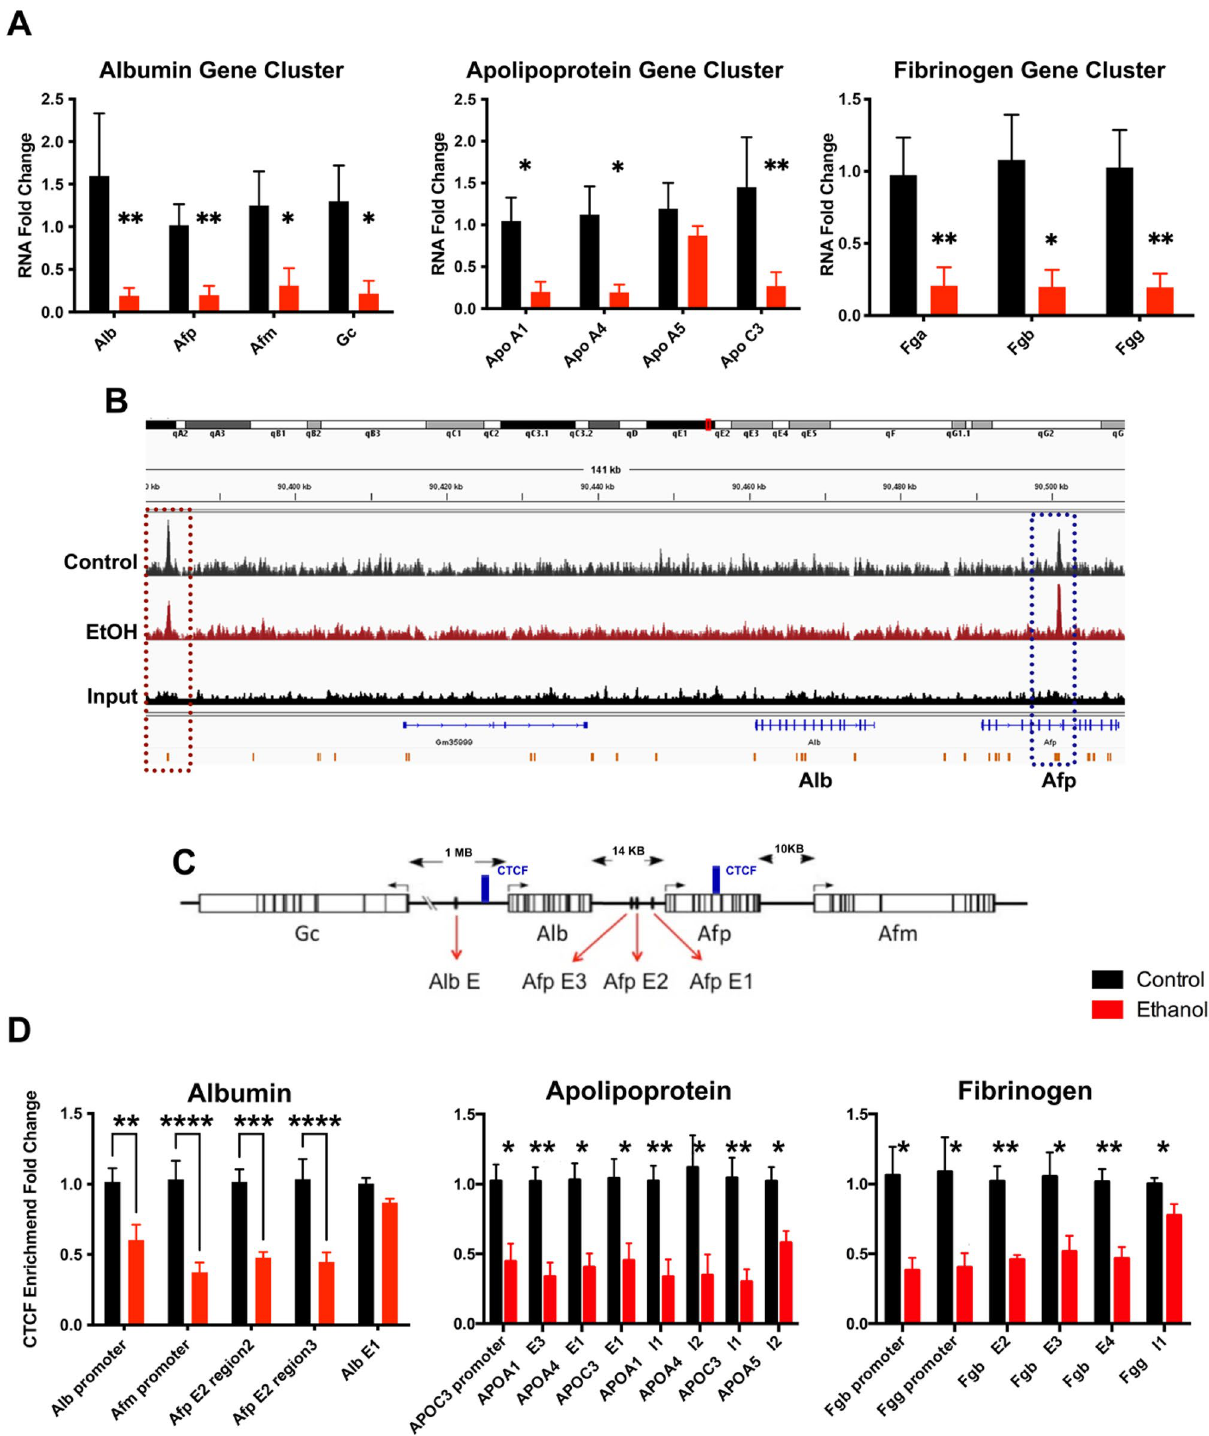
Figure 4. Preconception paternal alcohol exposure induces correlative patterns of altered gene expression and CTCF binding across the albumin, apolipoprotein, and fibrinogen gene clusters. ( A ) Using RT-qPCR and RNA samples isolated from male placentae derived from the offspring of EtOH-exposed sires, we assayed the expression of candidate genes within the albumin , apolipoprotein , and fibrinogen gene clusters. We normalized gene expression to the geometric mean of transcripts encoding Sdha , Mrpl1 , and Hprt and examined eight placentae from each treatment, derived from five different litters (n = 8). ( B ) Integrative Genome Viewer tracks showing altered CTCF enrichment within the albumin gene cluster. ( C ) Map of the albumin gene cluster with known CTCF peaks previously identified in mouse liver 48 demarcated in blue, and upstream enhancer regions identified by red arrows. Using qPCR, we measured CTCF enrichment within the albumin , apolipoprotein , and fibrinogen gene clusters. We assayed precipitated extracts for the enrichment of promoter regions, candidate Enhancers, or Insulators within the indicated loci. We performed ChIP experiments on eight placentae from each treatment, derived from five different litters (n = 8), and used a two-way ANOVA followed by an Uncorrected Fisher’s LSD. Error bars represent the standard error of the mean, * P < 0.05, ** P < 0.01, *** P < 0.001, **** P <